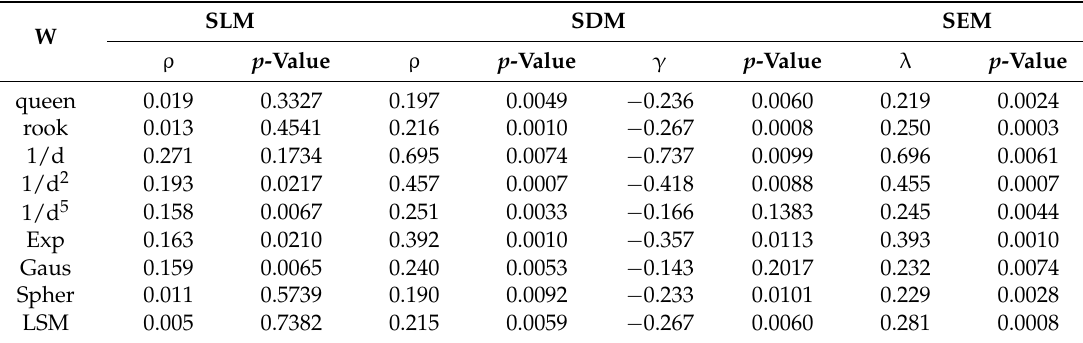
Table 7. Estimates of autoregressive parameter for nine spatial weight